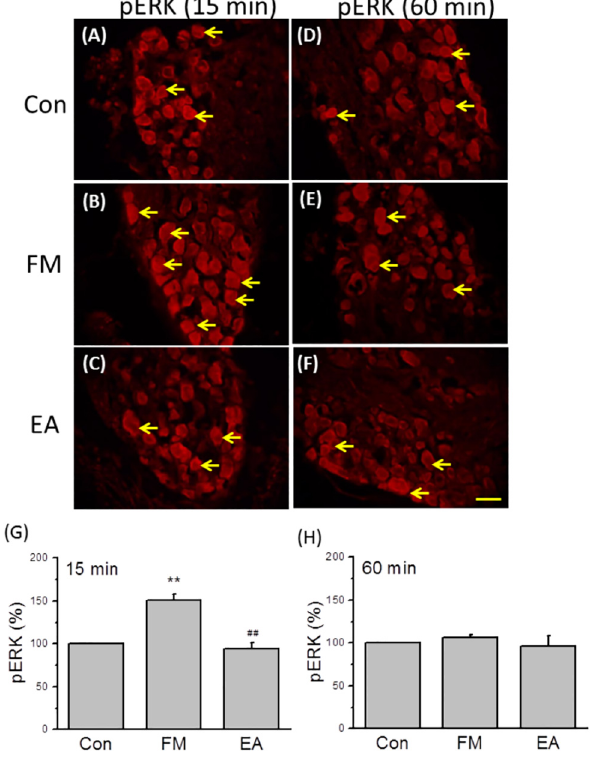
Fig 5. Protein expression of pERK in DRG neurons from Con, FM, and EA groups. (A-C) Immunohistochemical staining showing pERK-reactive cells in the L3-5 DRG of control (A), FM (B), and EA mice (C) 15 min after intramuscular injection of normal saline (control) or acid saline (FM and EA groups). (D-F) Immunohistochemical staining showing pERK-reactive neurons at 60 min after injection (red). (G, H) Proportions of immunopositive neurons. Con = Control; FM = acid induced fibromyalgia pain; EA = electroacupuncture. DRG = dorsal root ganglion. Arrows mean immuno-positive neurons. Scale bar = 50 μ